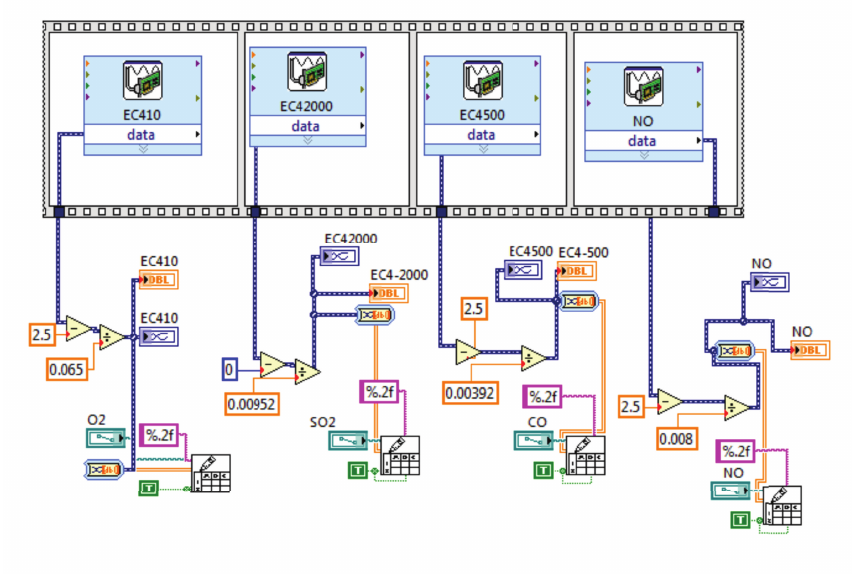
Figure 15: Sub-VI acquisition programing block.